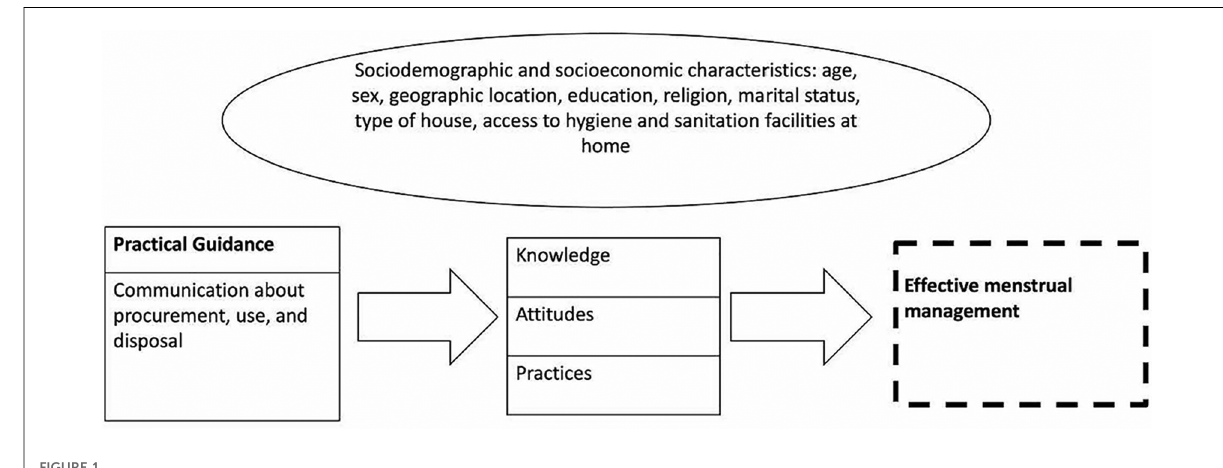
FIGURE 1 Menstrual management practical guidance conceptual